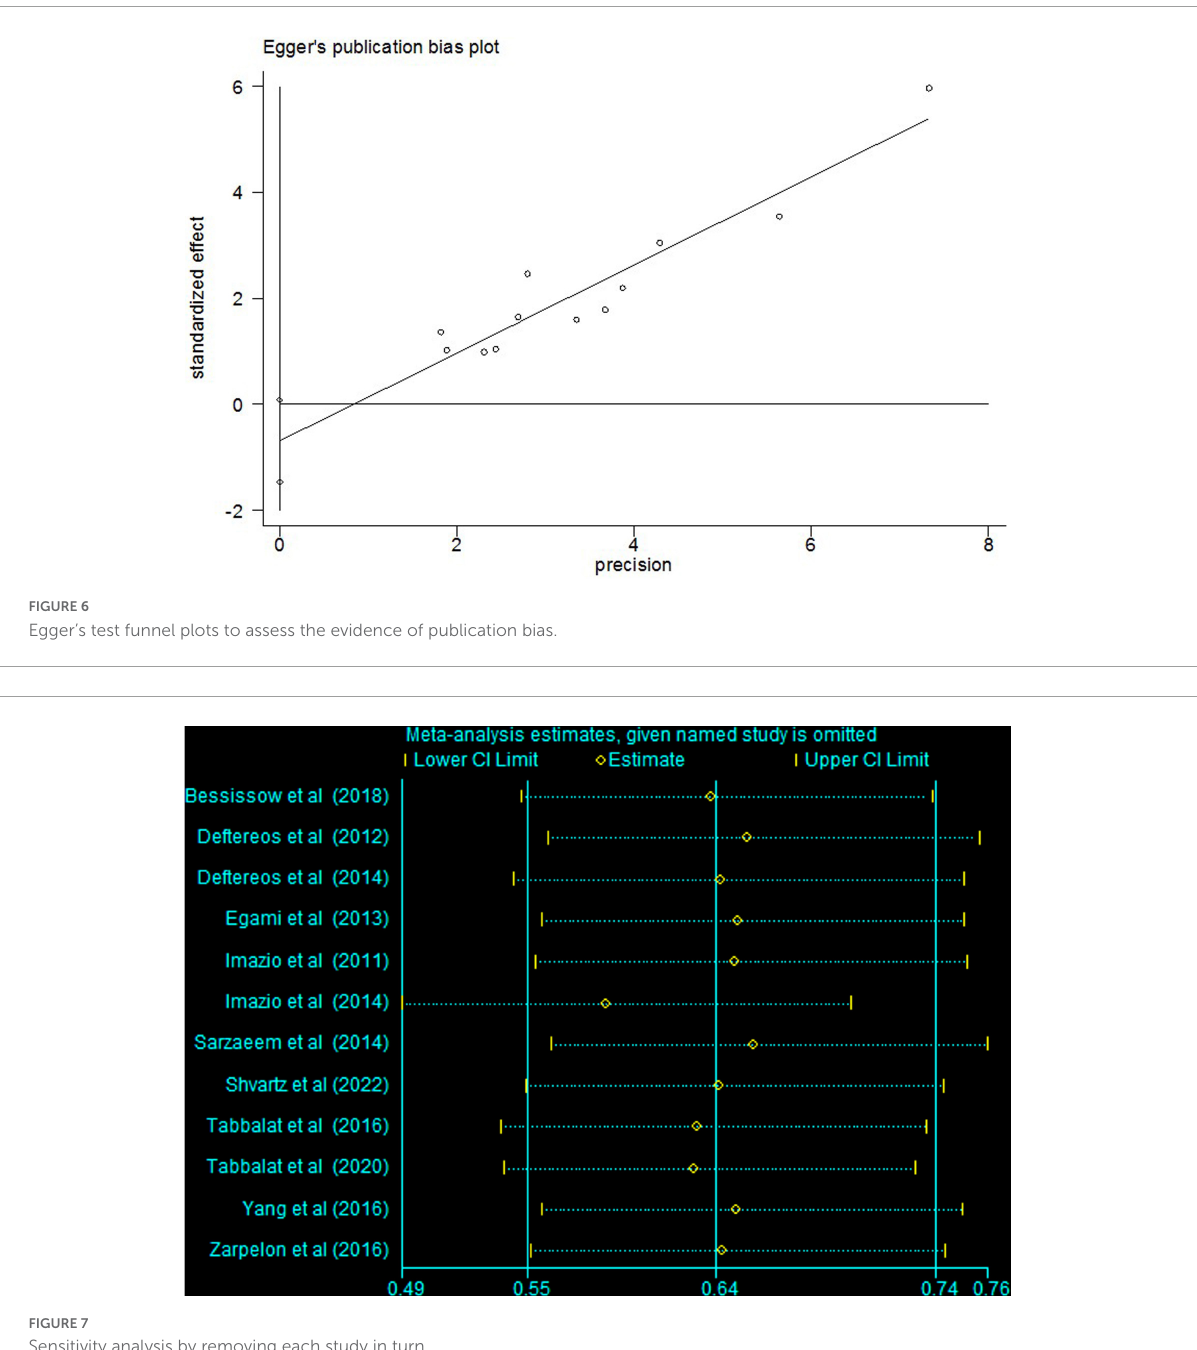
FIGURE7 Sensitivity analysis by removing each study in